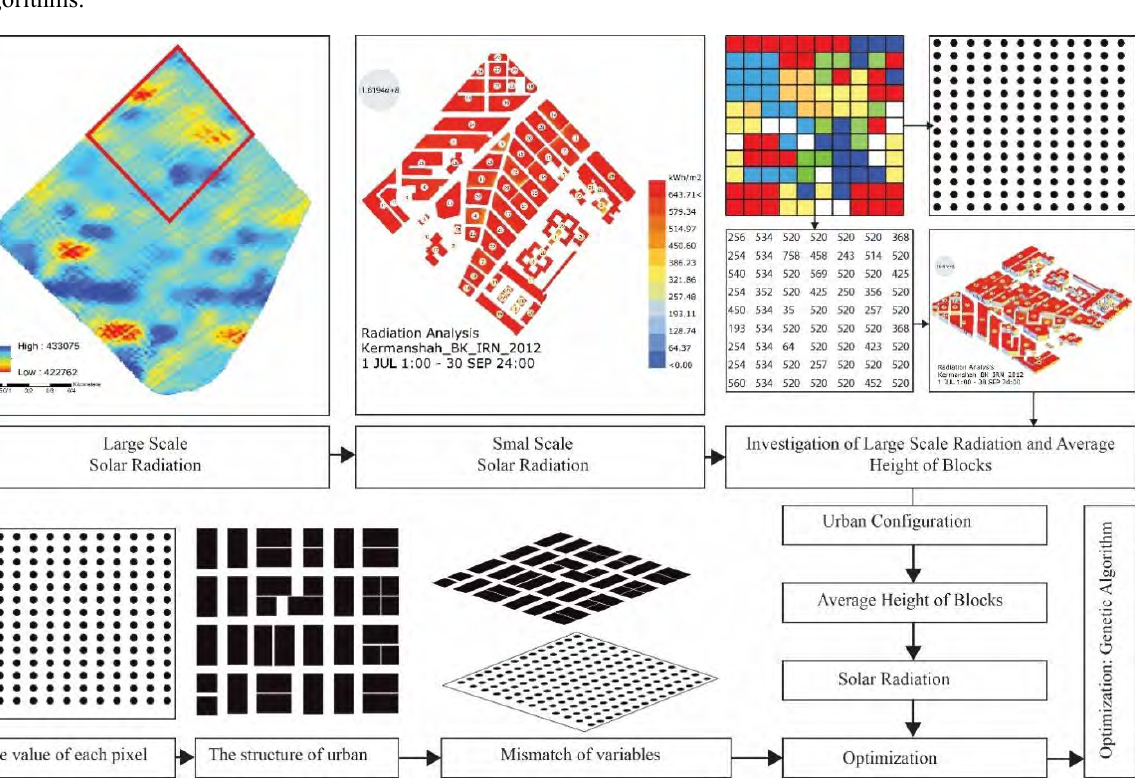
Figure 18 - Comparison of optimal winter and summer conditions related to height changes of group A from genetic algorithm analyses Our preliminary studies in Figure 19 demonstrated the influence of radiation absorption from the Earth morphology on the macro-level data. This study shows that radiation absorption in different seasons with the proper location in an urban block can be expected to increase up to 200%, which was beyond the scope of this study. Finally, the final analysis of this study is to match the macro-level data and the average height of existing and optimized blocks. In the process of optimization based on genetic algorithm, it was expected that in optimization based on genetic algorithm, height changes occur based on maximum solar radiation in correspondence to changes of solar radiation in the macro- level data, i.e., satellite data. Data analyzed via adaptation of the optimized data and the height change data (Figure 19) shows that these data did not change according to the satellite algorithm and the morphological structure of the Earth. In other words, these changes were not significant, indicating a need for further research tailored to adaptive algorithms.